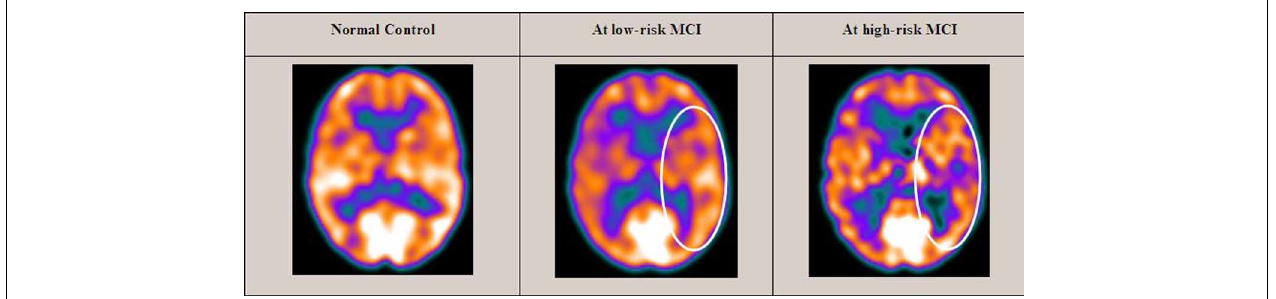
hypometabolism in one of the 14 at low risk and in one of the 13 at high risk MCI patient respect to one of the 17 enrolled controls.